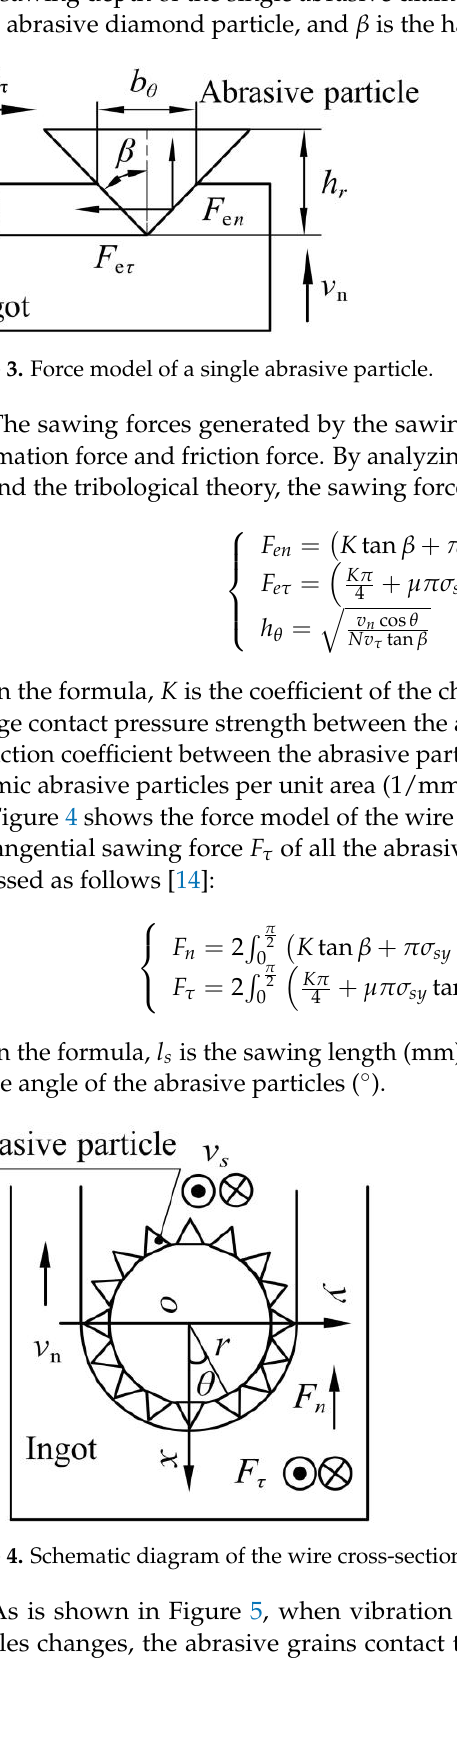
, where T is a single vibration